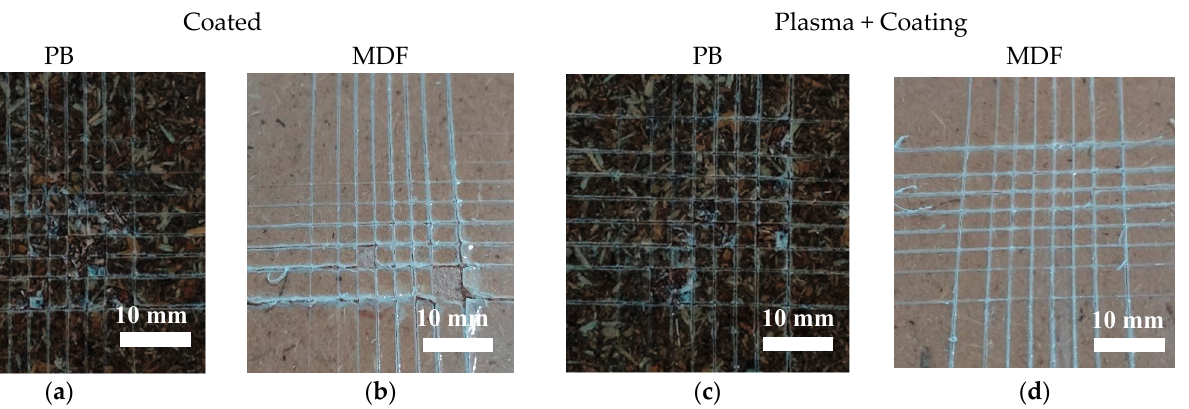
Figure 8. Scratch-adhesion test of coatings on ( a , b ) untreated and ( c , d ) plasma-treated PB and MDF samples at 10 mm nozzle distance and 15 kW plasma energy.